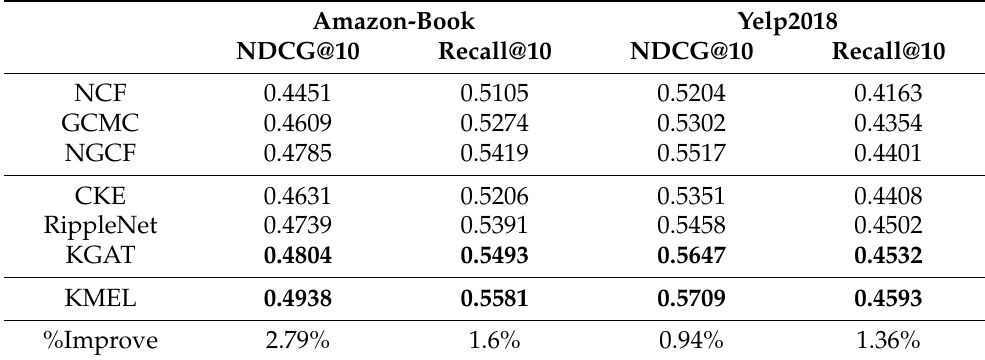
Figure 2. Performance comparison of Top-K recommendations by NDCG@K on Amazon-Book and Yelp2018 datasets, K = 1,2, . . . ,10. Table 2. Performance comparison by NDCG@10 and